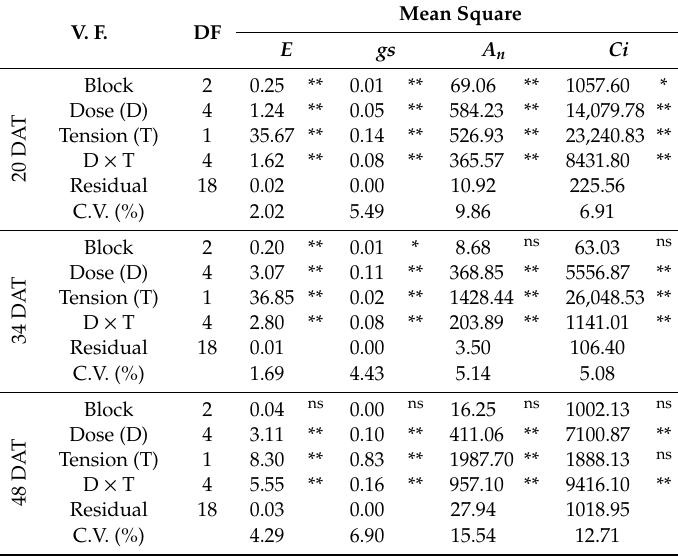
Table 2. ANOVA summary of the tomato gas exchange, namely, the transpiration rate ( E ), stomatal conductance ( gs ), internal CO 2 concentration ( Ci ), and net photosynthesis assimilation rate ( A n ) subjected to five doses of Si (0.0 (control), 1.0, 2.0, 3.0 and 4.0 g L − 1 ) and two soil water potentials ( − 30 and − 60 kPa), at 20, 34, and 48 DAT. V. F.